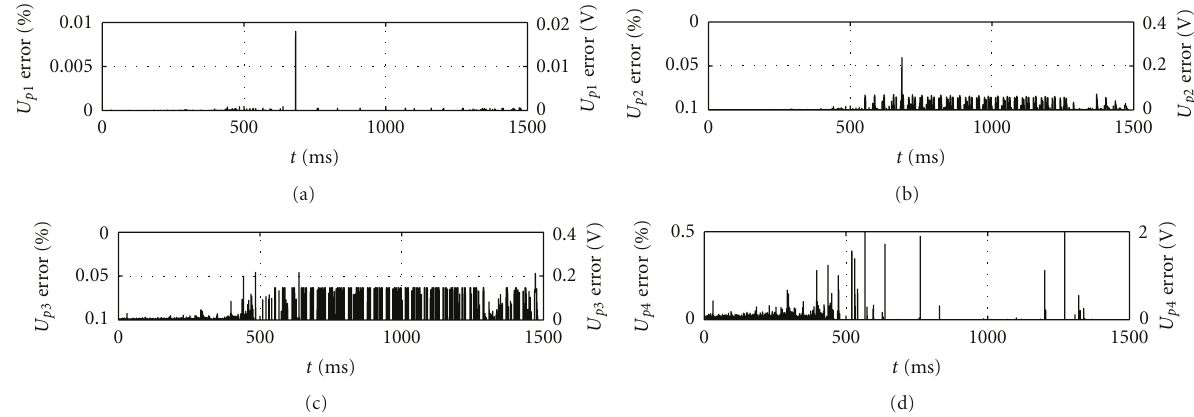
Figure 8: Comparison between simulation results using numerical solution and using approximations for a part of a real guitar ri ff . Only the error signals are displayed.